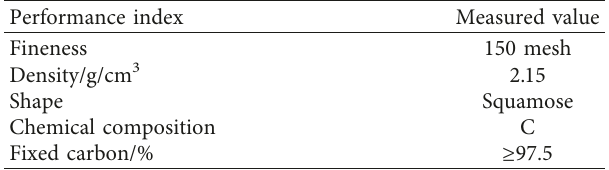
Table 2: Technical indexes of graphite.